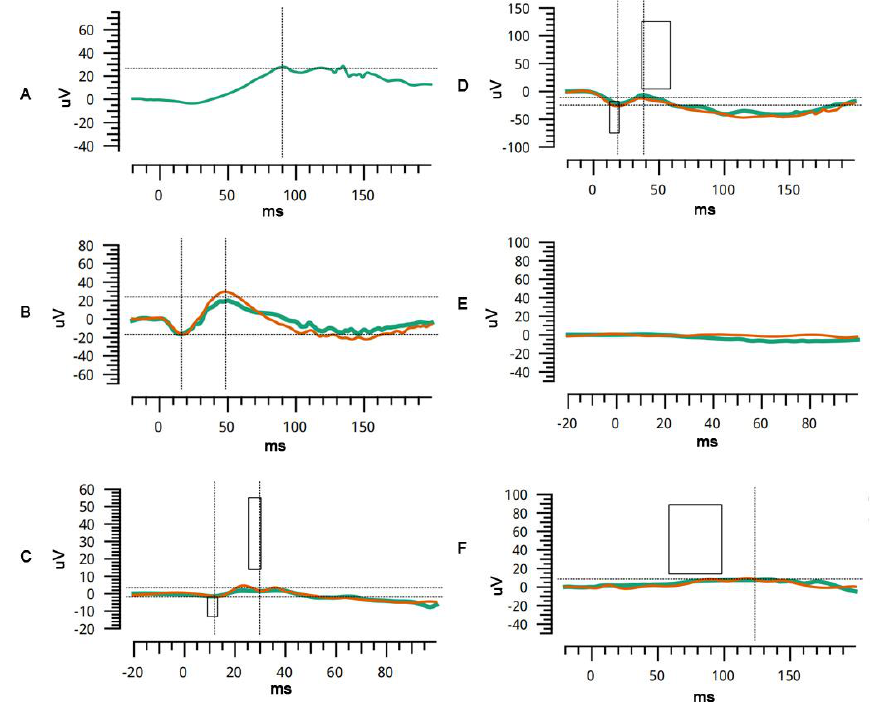
Figure 2. Characteristic ERG findings in patients with Knobloch Syndrome. In patient 3, rod-specific ERG (dark adapted 0.01, ( A )) and bright flash (dark adapted 3, ( B )) is mildly subnormal. Single flash (light adapted 3) showed severely diminished B-wave, indicating a major cone function impairment. ( C ) In patient 4, rod-specific ERG showed severe diminished on rod-specific ERG ( D ) and bright flash; ( E ) cone single flash was almost extinguished, ( F ) These results indicated the loss of function in both cone and rod photoreceptors.